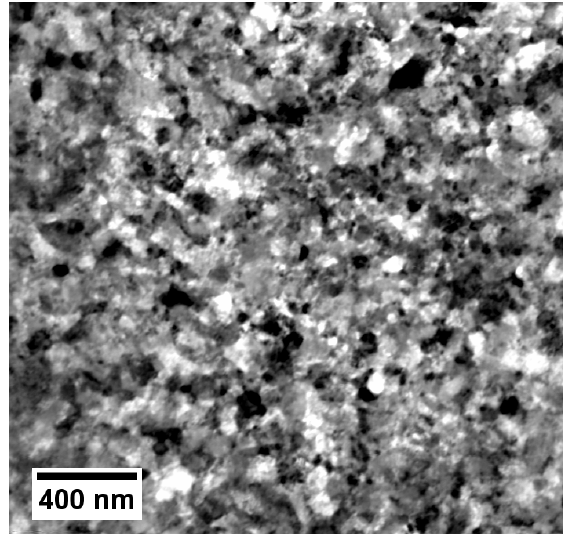
Figure 4. Orientation dark-field STEM image showing the microstructure of sample